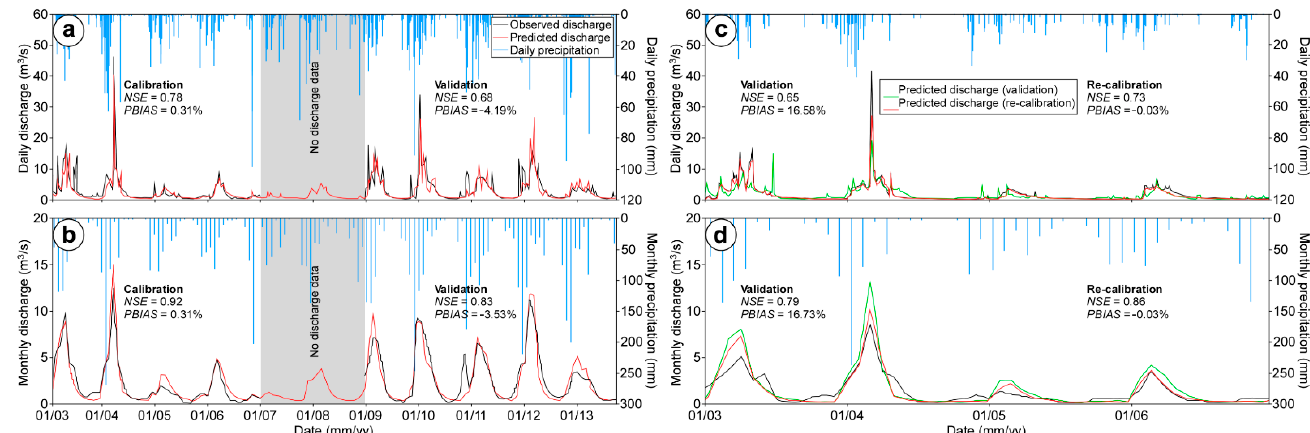
Figure 6. Observed and predicted discharge at ( a ) daily and ( b ) monthly time steps during the calibration (2003–2006) and validation (2009–2013) periods at the outlet of the Alata River Basin, where the grey shaded area indicates the period (1 January 2007–31 December 2008) over which discharge data was not available. The HYPE model’s spatial validation at the internal gauging station at ( c ) daily and ( d ) monthly time steps.